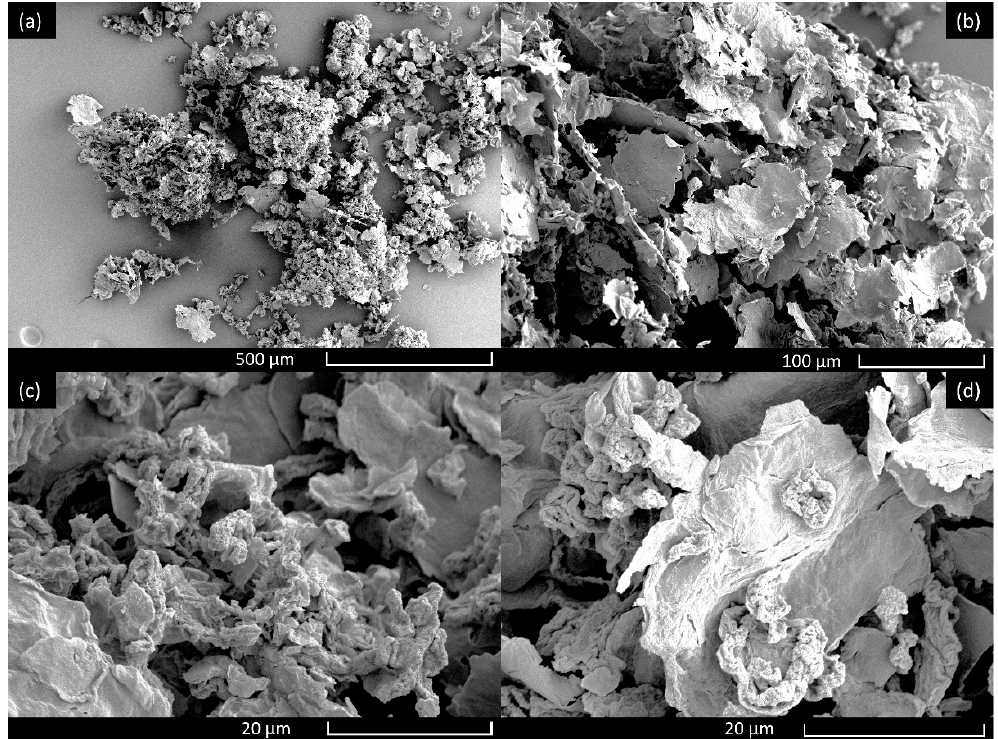
Figure 1. High magnification images of the unprocessed porous graphene shown at ( a ) 85 × magnification, ( b ) 320 × magnification, ( c ) 2100 × magnification and ( d ) 2300 × magnification.